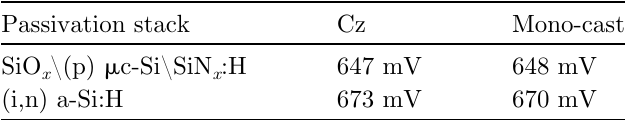
Table 4. Implied Voc of symmetric samples from Batches 3 and 4 for different passivation stacks on Cz and mono- cast